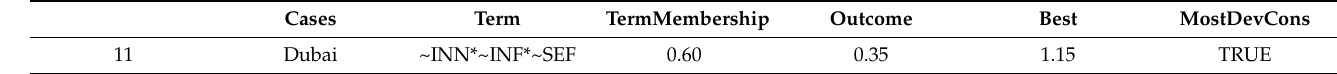
Table 7. Deviant Consistency Cases ~OVE.